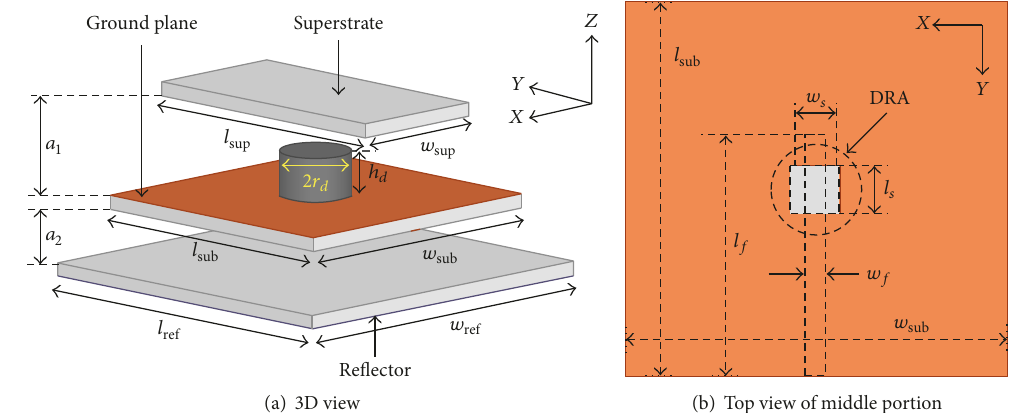
Figure 1: It illustrates the schematic diagram of the proposed dielectric resonator